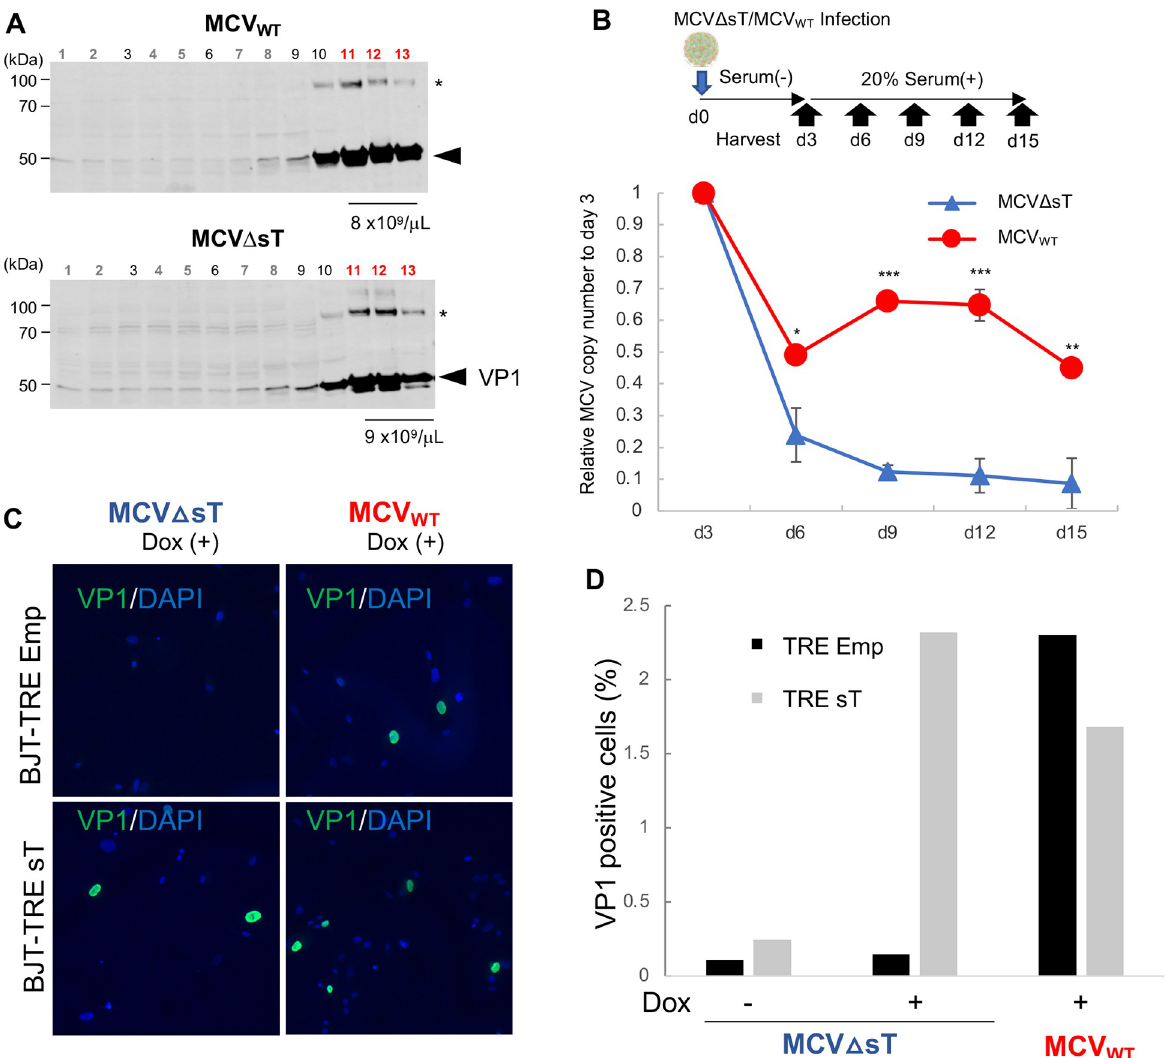
Fig 5. sT regulates VP1 expression in infected permissive cells. (A) Production of MCV Δ sT and MCV WT virions in transfected 293 TRE-sT cells with sT protein induction. Thirteen fractions from MCV Δ sT- and MCV WT -transfected 293 TRE-sT cell lysates sedimented by Opti-prep (1~13 from lighter to heavier) demonstrate similar virion packaging efficiency in fractions 11~13 between MCV WT and MCV Δ sT according to VP1 protein expression and genome copy numbers from the pooled fractions (fractions 11~13). VP1 protein was detected by CM9B2 by immunoblot, and absolute MCV genome copy number was determined by qPCR with a VP2 primer (set 1) pair. � VP1 dimer protein. (B) BJ.hTERT cells were infected with 10 6 per cell genome copies of MCV Δ sT and MCV WT and harvested over a time period of 15 days after the addition of serum on day 3 post infection (top panel). qPCR was performed on genomic DNA using the 2 - ΔΔ Ct method with GAPDH for normalization. A relative MCV DNA abundance to the day 3 post-MCV-infected sample indicates the inability of MCV Δ sT to maintain the viral genome. Significance was determined by unpaired T test in comparison between MCV Δ sT and MCV WT within the same date point � , P < 0.05; �� , P < 0.01; ��� , P < 0.001. (C) Exogenous sT rescues VP1 protein expression in MCV Δ sT infected cells. BJ.hTERT TRE-Emp and TRE-sT cells infected with MCV Δ sT and MCV WT were treated with doxycycline at day 5 p.t. to induce exogenous sT expression. Cells were harvested at day 8 for immunofluorescence with VP1 antibody. (D) Doxycycline (Dox) rescues VP1 expression in the MCV Δ sT mutant to levels greater than that of MCV WT . VP1 positive cells were counted to determine %